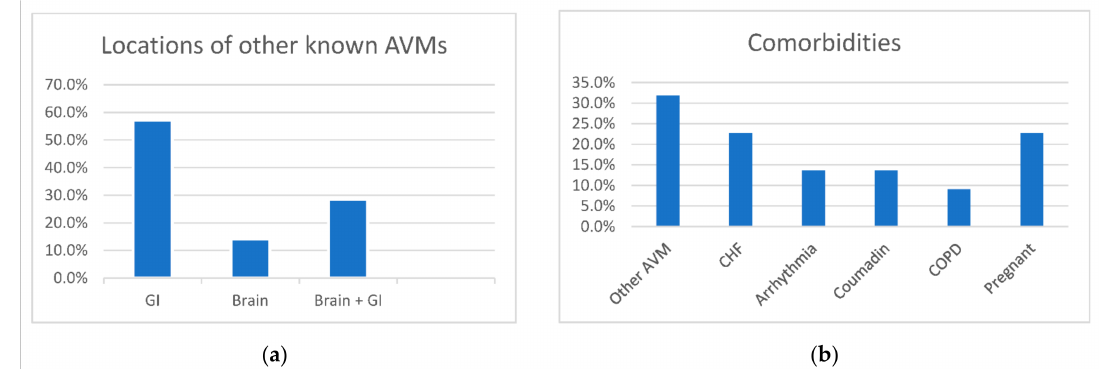
Figure 2. Bar graphs demonstrating the locations of other ( a ) AVMs and ( b ) co-morbidities in HHT patients with rup- tured pulmonary AVMs. (AVM—arteriovenous malformations, CHF—chronic heart failure, COPD—chronic obstructive pulmonary disease, GI—Gastrointestinal).